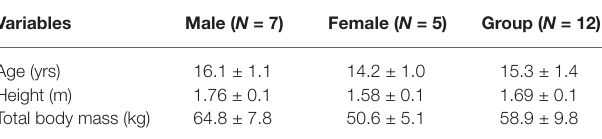
TABLE 1 | Anthropometric (mean ± SD) characteristics of the participants.